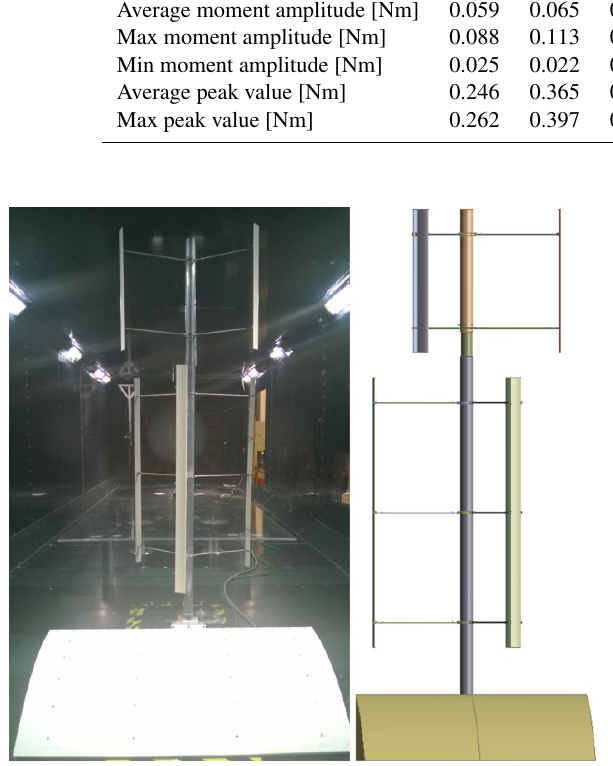
Figure 7. Model set in configuration